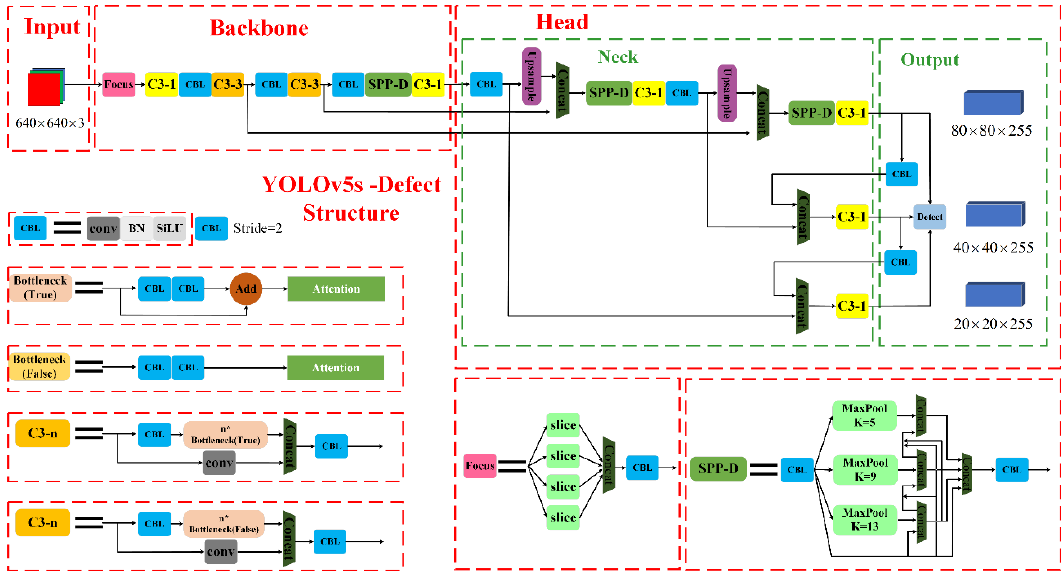
Figure 13. Structure diagram of the improved YOLOv5s-Small-Target network model.